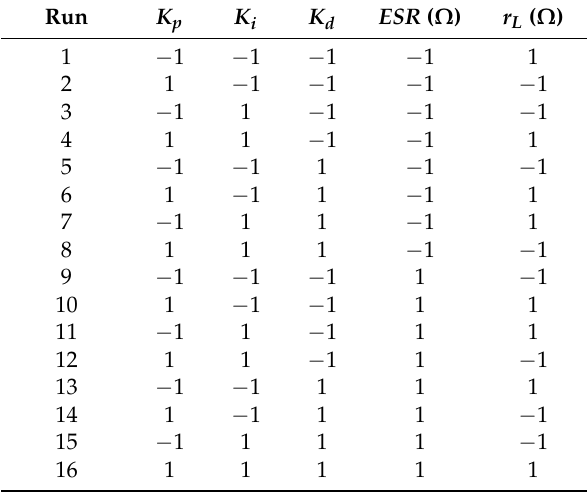
Table 2. Combined array collected from the cloud data base.